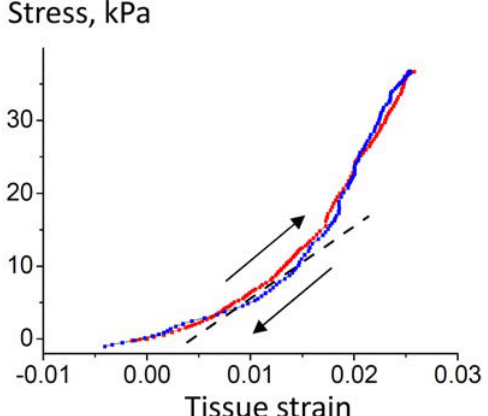
Fig. 6. Experimental data showing nonlinear-elastic stress – strain behavior obtained using compressional OCE, with a sil- icone reference layer overlying an excised breast cancer tissue sample. Note that the tissue Young modulus @(cid:3)=@" varies greatly (range (cid:3) 400 – 1400 kPa), although the strain range is modest < 2 : 5%. The slope of the dashed line corresponds to the mid-range Young modulus value of (cid:3) 1000 kPa. For compari- son, the sti®er silicone reference layer had E (cid:3) 200 kPa. Arrows indicate loading (upward) and unloading (downward) tissue response; their near-overlap shows no hysteresis in this breast cancer tissue (for details, see